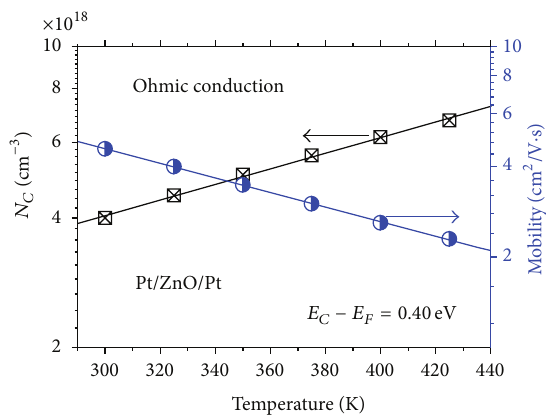
Figure 23: Temperature dependence of the electron mobility and the effective density of states of the conduction band in low resistance state in Pt/ZnO/Pt memory devices.